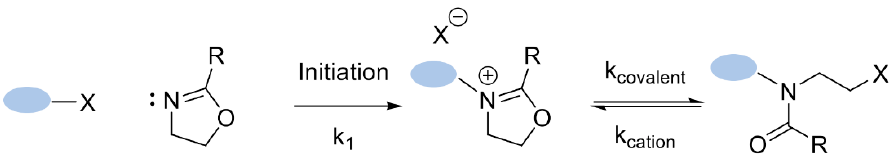
Figure 5. The initiation of the living cationic ring-opening polymerization (CROP) of 2-oxazoline monomers. Equilibrium between the cationic and covalent molecules depends on the counter ion. Adapted from [12].